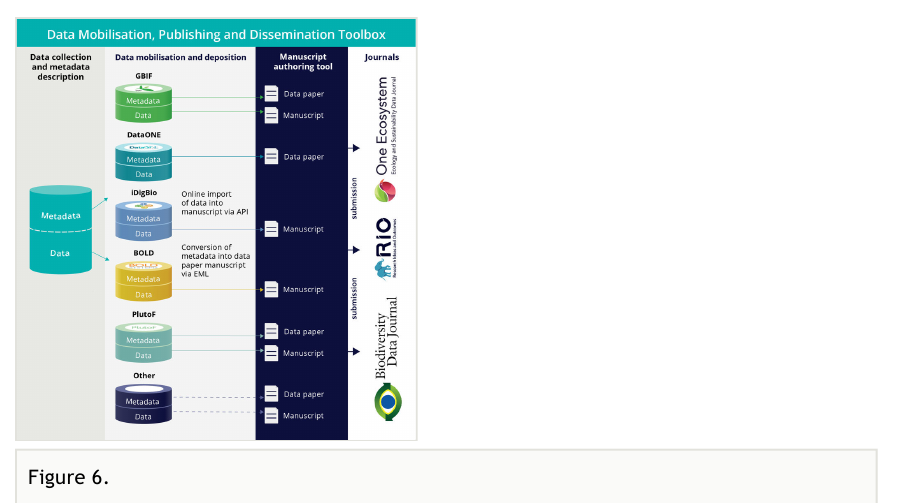
The ARPHA Writing Tool provides online direct import from external databases using community-accepted standards (e.g. within the biodiversity community, these are Darwin Core, TaxPub JATS extension and others - see http://www.tdwg.org/standards/). Initially, data import was from CSV spreadsheets or manually via a Darwin Core HTML editor (Penev et al. 2017). A new functionality of the integrated data publishing system in ARPHA is the online import of specimen records from GBIF, Barcode of Life, iDigBio and PlutoF (Fig. 6). The work fl ow is described in Senderov et al. (2016). Stepwise guidelines on how to use the feature are also available from Penev et al. (2017) and a blog post.